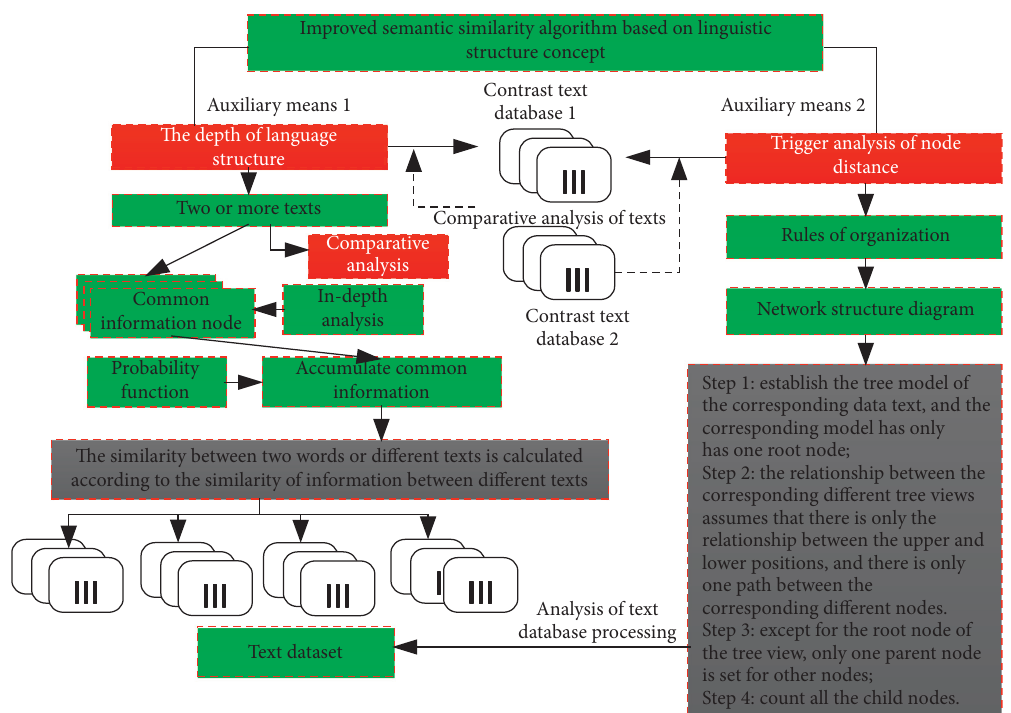
Figure 2: Schematic diagram of the improved semantic similarity algorithm based on linguistic concept structure.